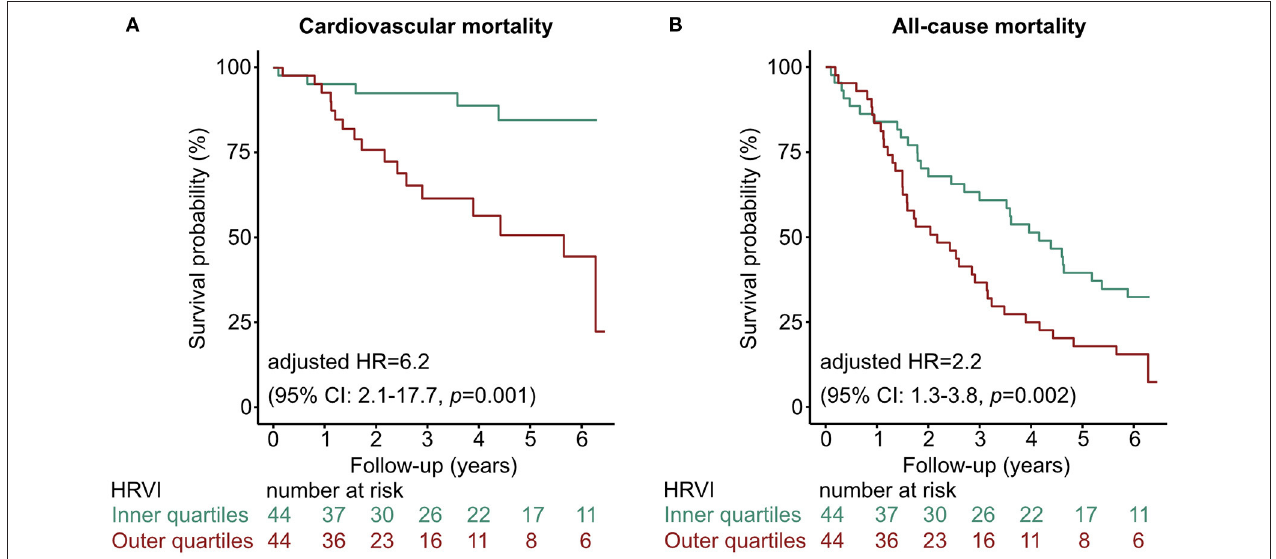
FIGURE 3 | Kaplan-Meier curves of the inner vs. outer quartiles of HRVI for (A) cardiovascular mortality and (B) all-cause mortality. Hazard ratio after adjustment for the Charlson Comorbidity Index and the Cardiovascular Mortality Risk Score . CI, confidence interval; HR, hazard ratio; HRVI, heart rate variability triangular index.